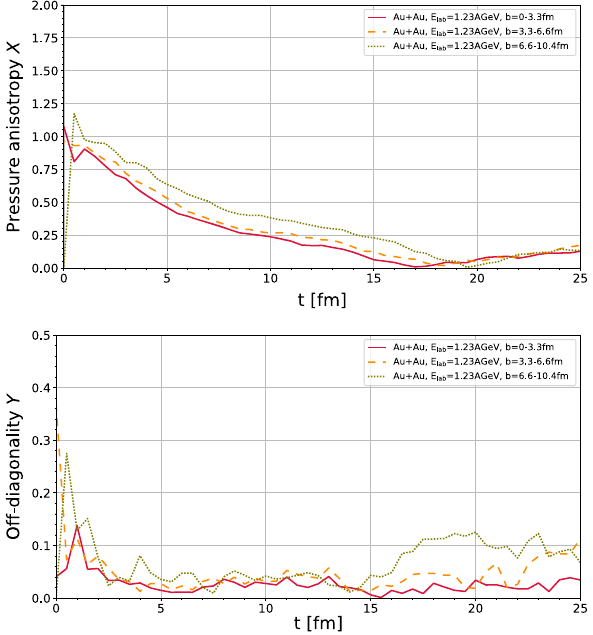
Fig. 6 Time evolution of the pressure anisotropy X and of the off- diagonality Y in the center of the system for Au+Au collisions at E lab = 1.23 AGeV, 0–5%, 5–20% and 20–50% centrality classes